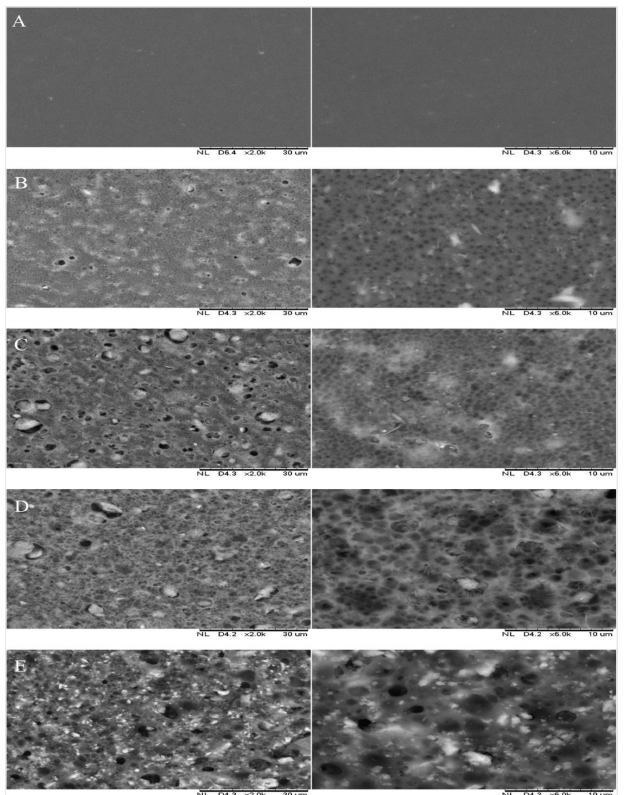
Figure 2. SEM surface images of ( A ) PES, ( B ) HH0.5, ( C ) HH1.0, ( D ) HH1.5 and ( E ) HH2.0 at 2000 × and 6000 × magnifications.